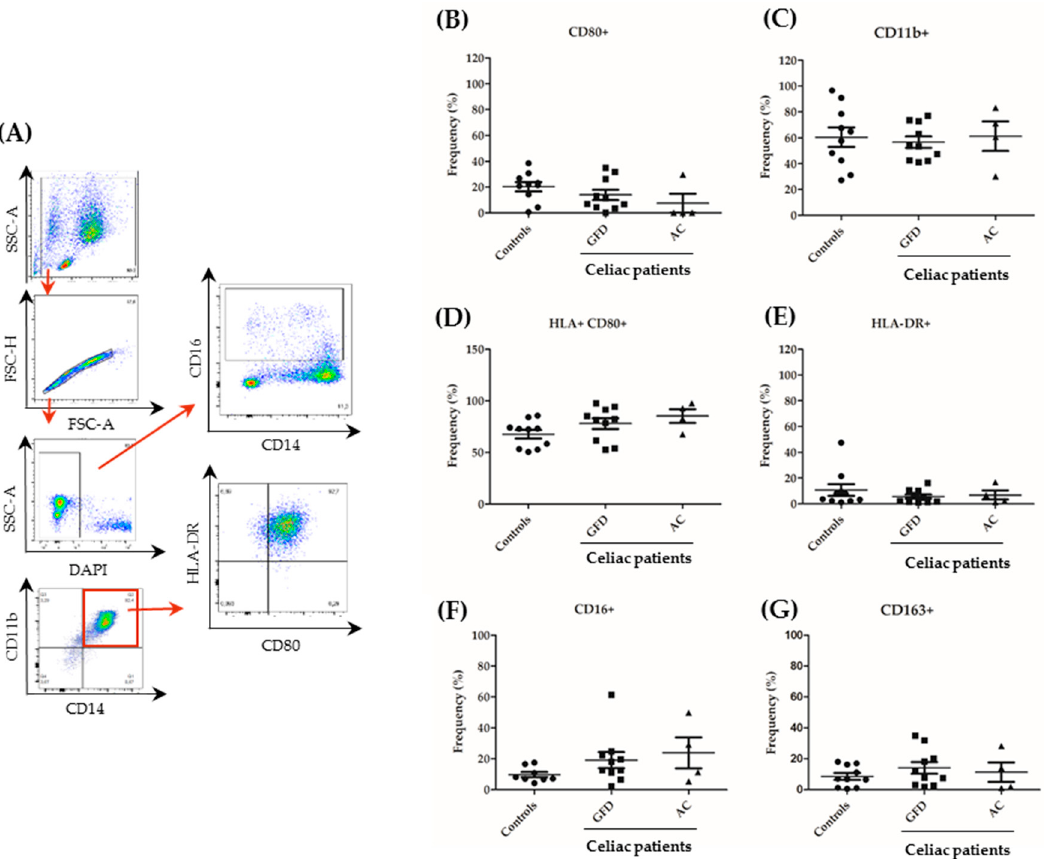
Figure 3. Expression of surface markers in peripheral monocytes from celiac patients. PBMCs were isolated from 10 controls, 10 GFD and 4 active CeD (AC) patients and sorted for CD14. Subsequently, cells were cultured in the presence of granulocyte macrophage colony stimulating factor (GM-CSF; 10 ng/ml) for 24 h and evaluated by flow cytometry. ( A ) Gating strategy used to determine surface marker expression. The stepwise gating approach is highlighted by various steps of analysis that are interconnected by red arrows. Representative plots from a healthy control are shown. ( B – G ) Results for the expression of single surface markers are shown. Each dot represents the surface marker expression result of a single patient. Mean values ± standard error of the mean (SEM) are shown. The Mann–Whitney U test revealed no significant differences.